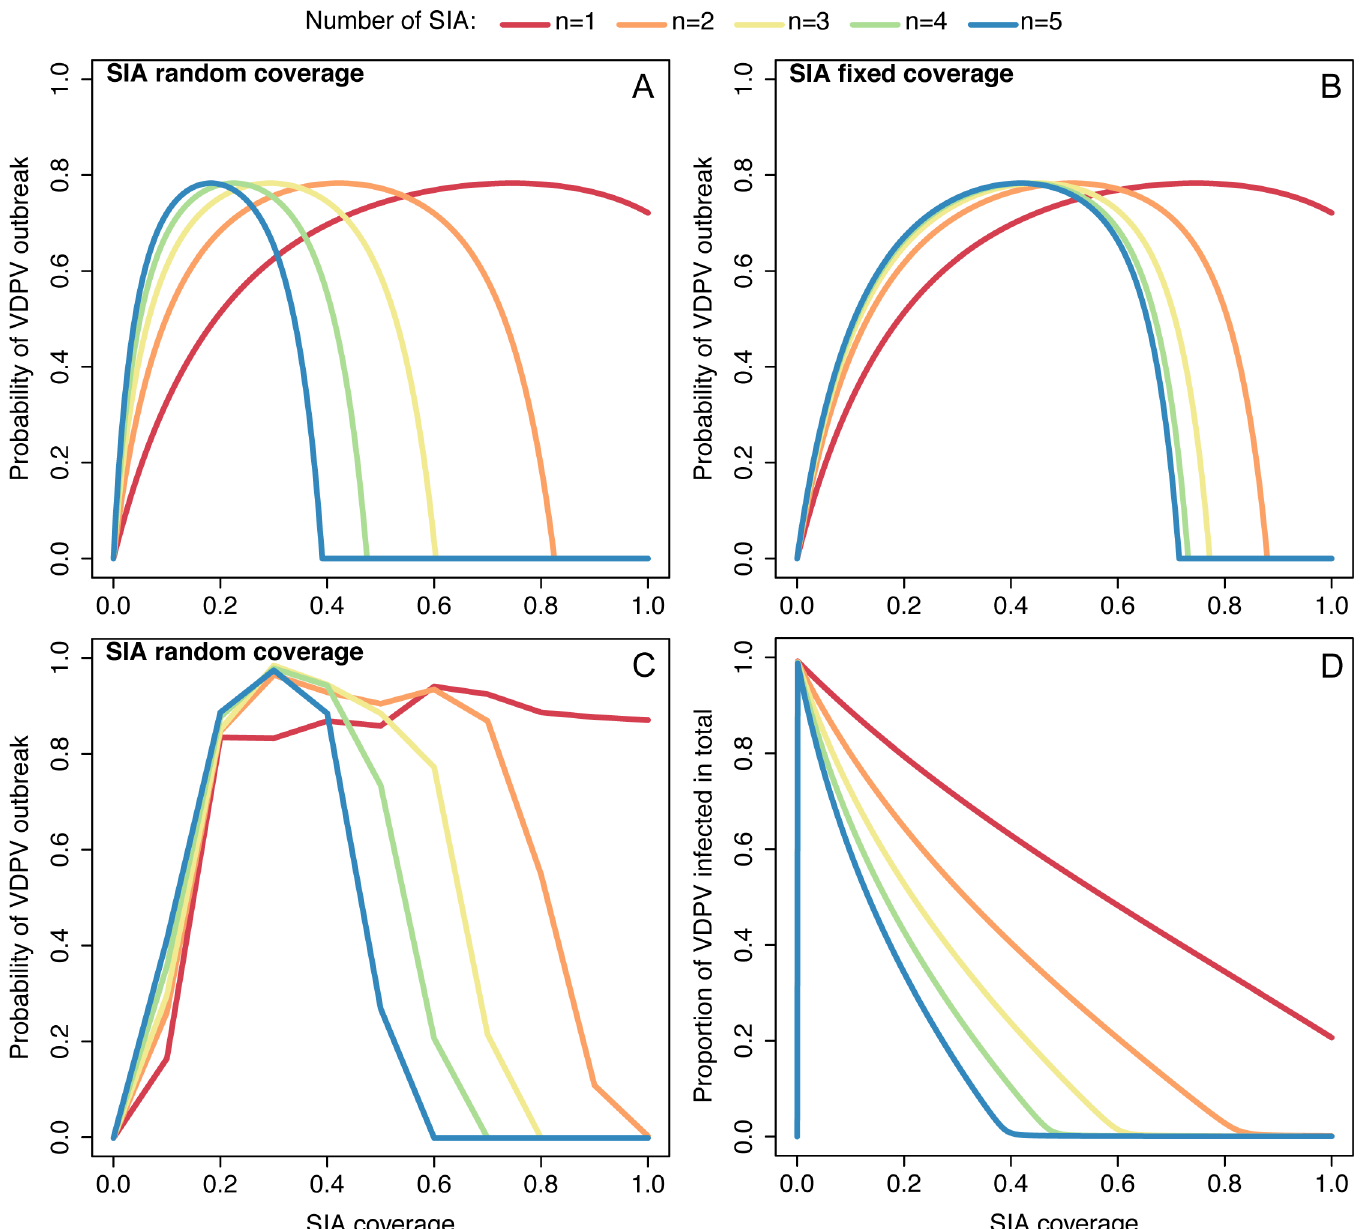
Fig 2. Probability of VDPV outbreak as a function of SIA coverage for scenarios with no routine immunisation. (A) Results for the analytical model assuming that each SIA reaches the same proportion of the population consisting of randomly chosen individuals at each round (SIA random coverage). (B) Results for the analytical model assuming that SIAs reach the same individuals at each round (SIA fixed coverage) with secondary spread of Sabin virus to the “ missed ” group. (C) Results for the stochastic dynamic model assuming SIA random coverage. (D) Proportion of individuals infected with VDPV (outbreak size) for the analytical model assuming SIA random coverage. The colours correspond to different number of SIAs. The simulations assume σ = 5, which corresponds for example to a population of 10,000 individuals and a probability of Sabin reversion to VDPV of ρ = 5×10 − 4 . A sensitivity analysis to the value of σ is provided in Fig B in S1